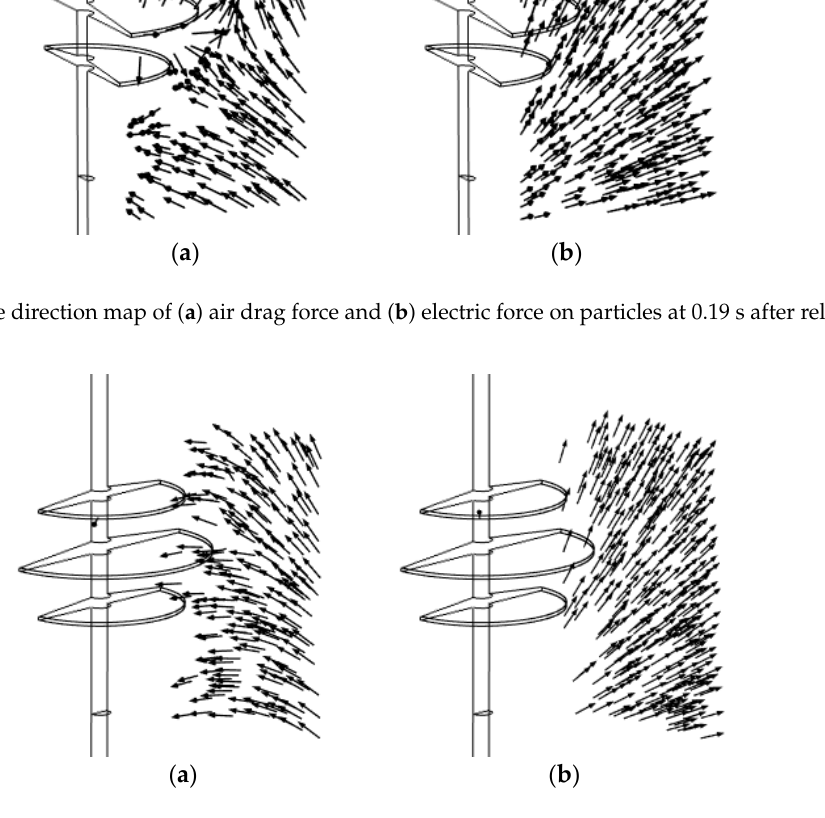
Figure 8. The curves of drag force and electric field force on the particles with different Q.